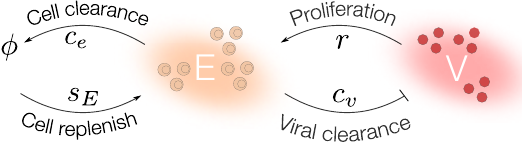
Figure 4. Viral infection model with CTLs response. IAV ( V ) induces CTLs ( E ) clonal expansion with a rate r which inhibits the viral replication through the clearance of the infected cell, this effect can be included in c v . CTLs are replenished with rate s E and die with rate c e